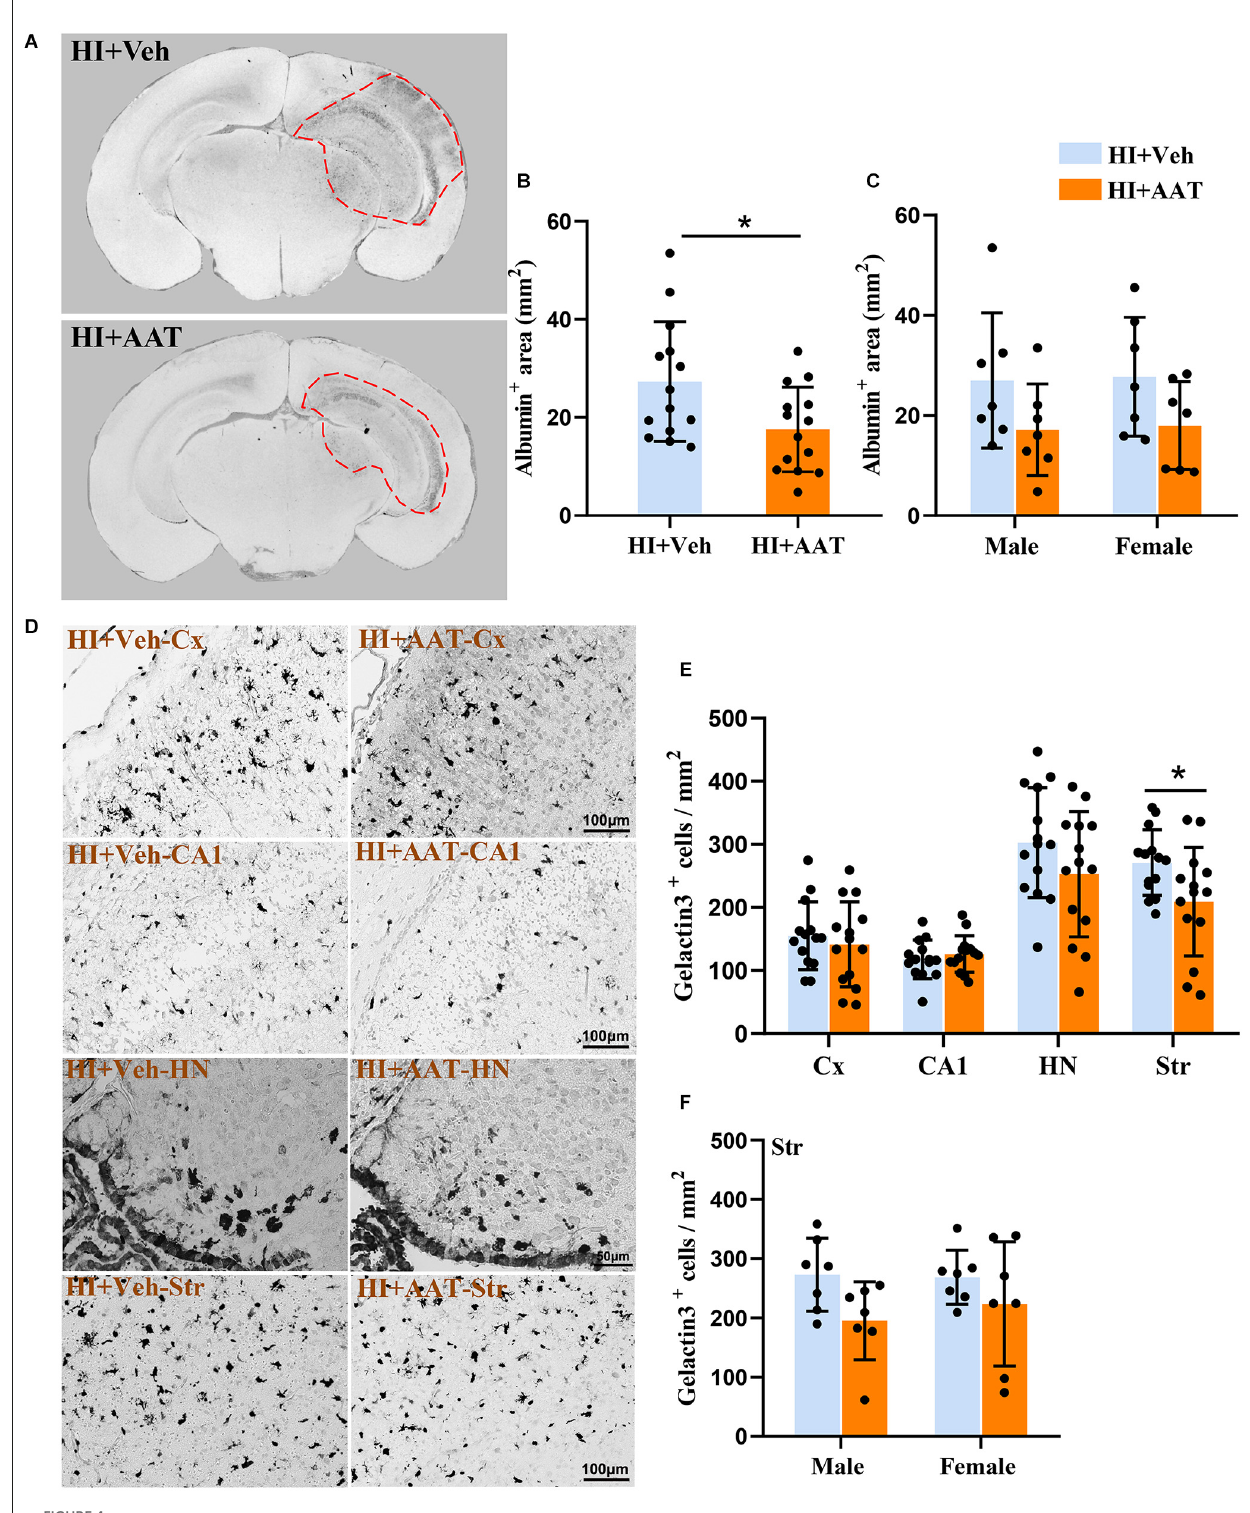
FIGURE4 Albumin extravasation and microglia activation in neonatal HI mice after AAT treatment. (A) Representative pictures at the hippocampal level showing the albumin-positive areas in the neonatal mouse brain at 24 h after HI in vehicle-treated and AAT-treated groups. (B) Measurement of the albumin- positive area at 24 h after HI ( n = 14/group, p = 0.022). (C) Measurement of the albumin-positive area at 24 h after HI in male and female mice ( n = 7/group, p = 0.107 for males and p = 0.111 for females). (D) Representative images showing the immunochemistry staining of activated macroglia in the cortex (Cx), hippocampus (CA1), habenula nucleus (HN), and striatum (Str) at 24 h after HI in the vehicle-treated and AAT-treated groups. (E) Quantification of galectin-3-positive cells at 24 h after HI in the Cx, CA1, HN, and Str [ n = 14/group, Cx ( p = 0.508), CA1 ( p = 0.464), HN ( p = 0.172), Str ( p = 0.03)]. (F) Quantification of galectin-3-positive cells in the striatum area at 24 h after HI in male and female mice ( n = 7/group, p = 0.057 for males and p = 0.262 for females). * p <